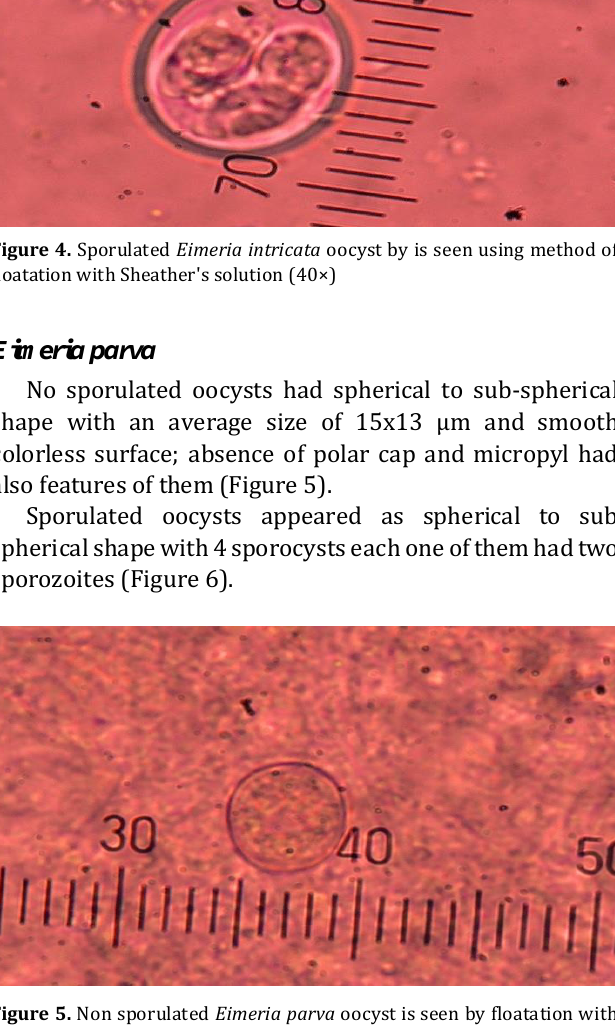
Figure 8. Sporulated Eimeria sordida oocyst using method of floatation with sheathers solution (40×) D